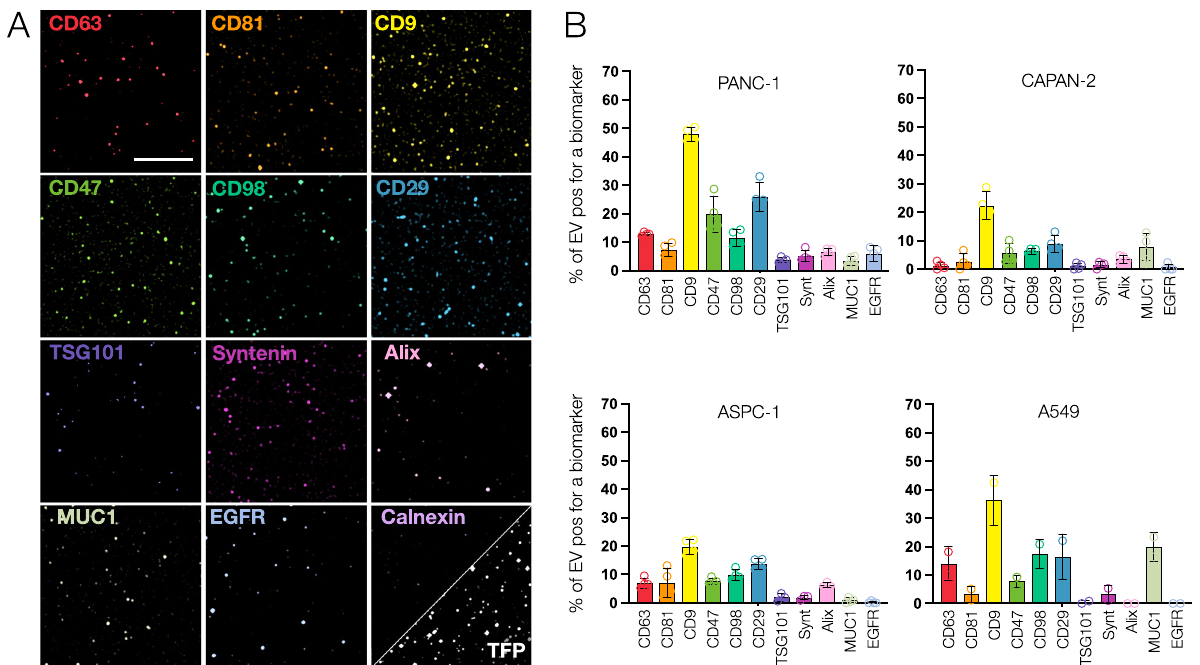
Fig. 3 | Ubiquitous biomarker analysis in single EV across different cell lines. A High magni fi cation images of EV (obtained from the PANC-1 cell line) for 12 biomarkers. Scale bar: 50 µ m B Quantitative analysis. Each graph shows the abun- dance of the indicated biomarker as a percentage of all EV (error bar: mean± standard deviation). EV were harvested from PANC-1, CAPAN2, ASPC1, and A549